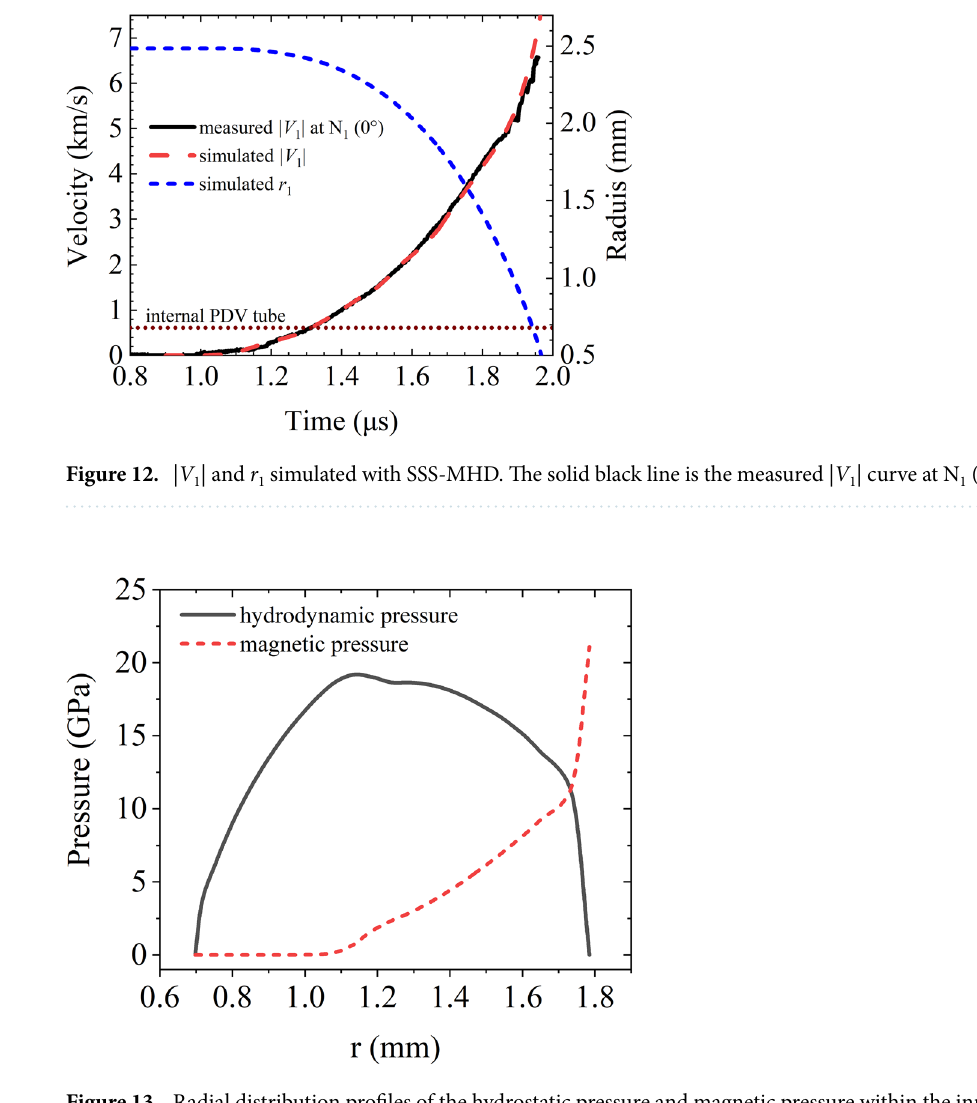
Figure 13. Radial distribution profiles of the hydrostatic pressure and magnetic pressure within the inner liner at a time of 1.94